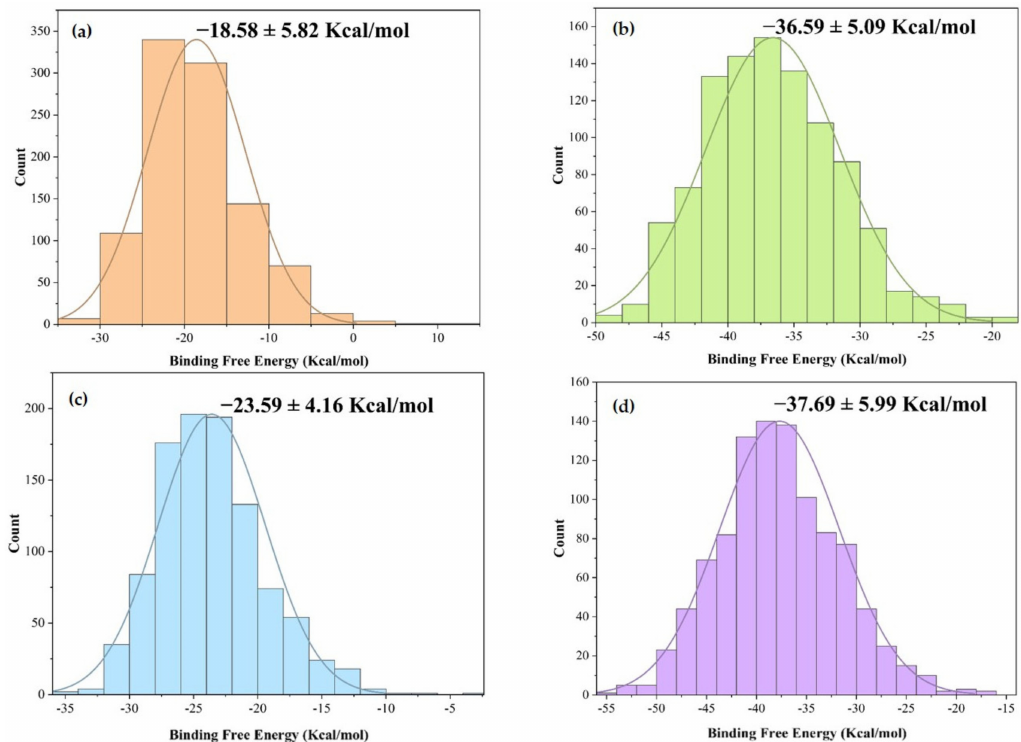
Figure 6. Histogram of the binding free energy value obtained for ( a ) CB1– α -amyrin; ( b ) CB1– α amyrin acetate; ( c ) CB1–friedelin; ( d ) CB1–THC, where bell-shaped curves represent a Gaussian